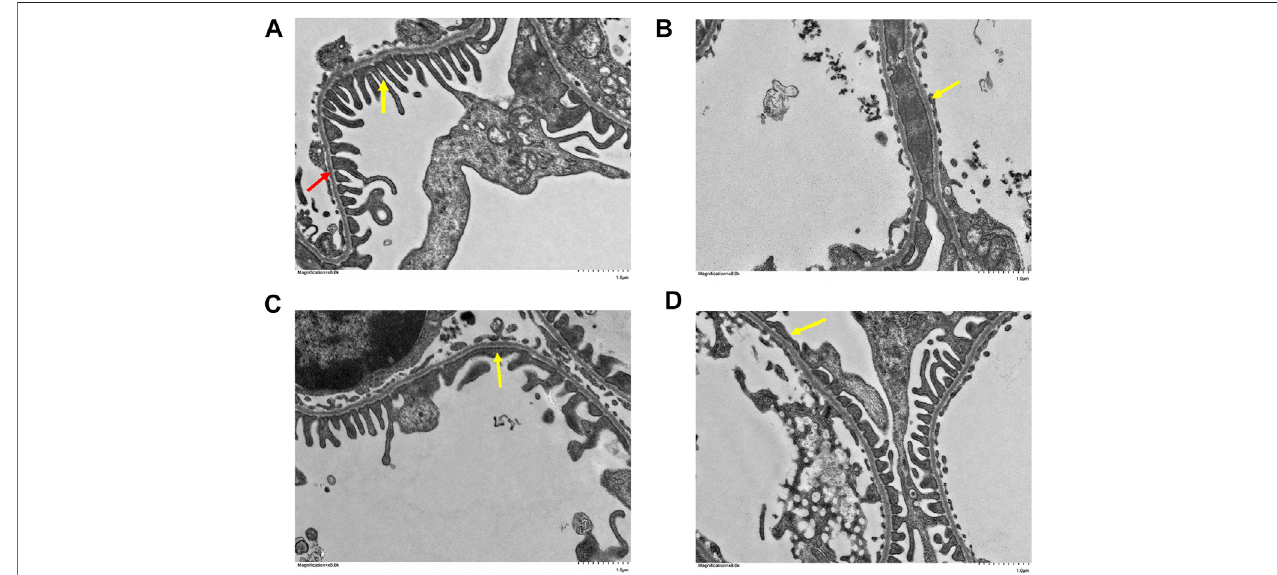
FIGURE5 | Glomerular foot cell changesunder electron microscopyin each groupat magni fi cation × 8,000.The yellow arrow points tothe foot processes and the red arrow to the basement membrane. (A) control group (B) model group (C) benazepril group (D) QRKSG group.